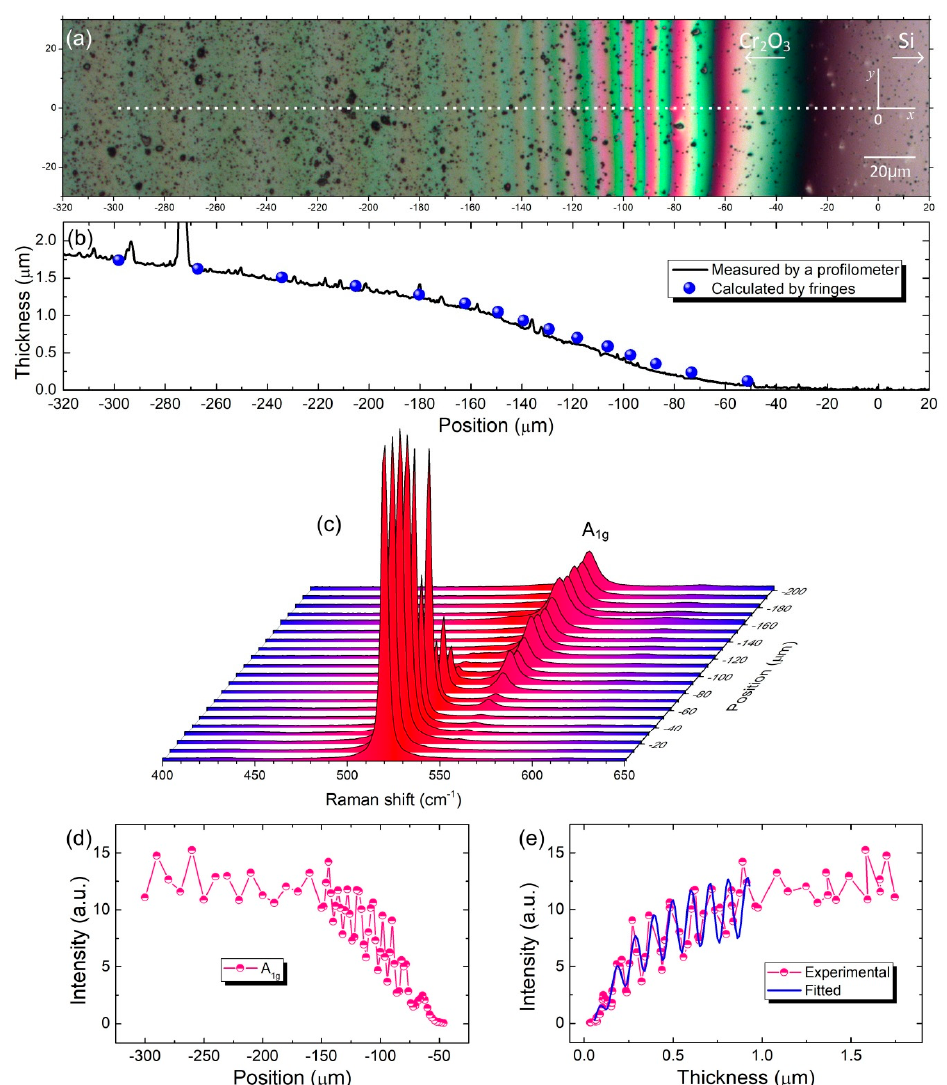
Figure 3. ( a ) Optical microscope images of the depositional edge zone of the Cr 2 O 3 coating, with the white dashed line indicating the position scanned by the Raman line; ( b ) Variation of coating thickness with the position in the depositional edge zone, where the solid black line denotes the results measured by the profilometer and the blue sphere denotes the results calculated according to the series of the interference fringes; ( c ) Variation of intensity of the Raman peak with the position in the depositional edge zone; ( d ) Variation of integral intensity of the A 1g mode of Cr 2 O 3 with position; ( e ) Variation of integral intensity of the A 1g mode with the thickness of the Cr 2 O 3 coating (circle) and the fitted curve by Equation (2) (blue